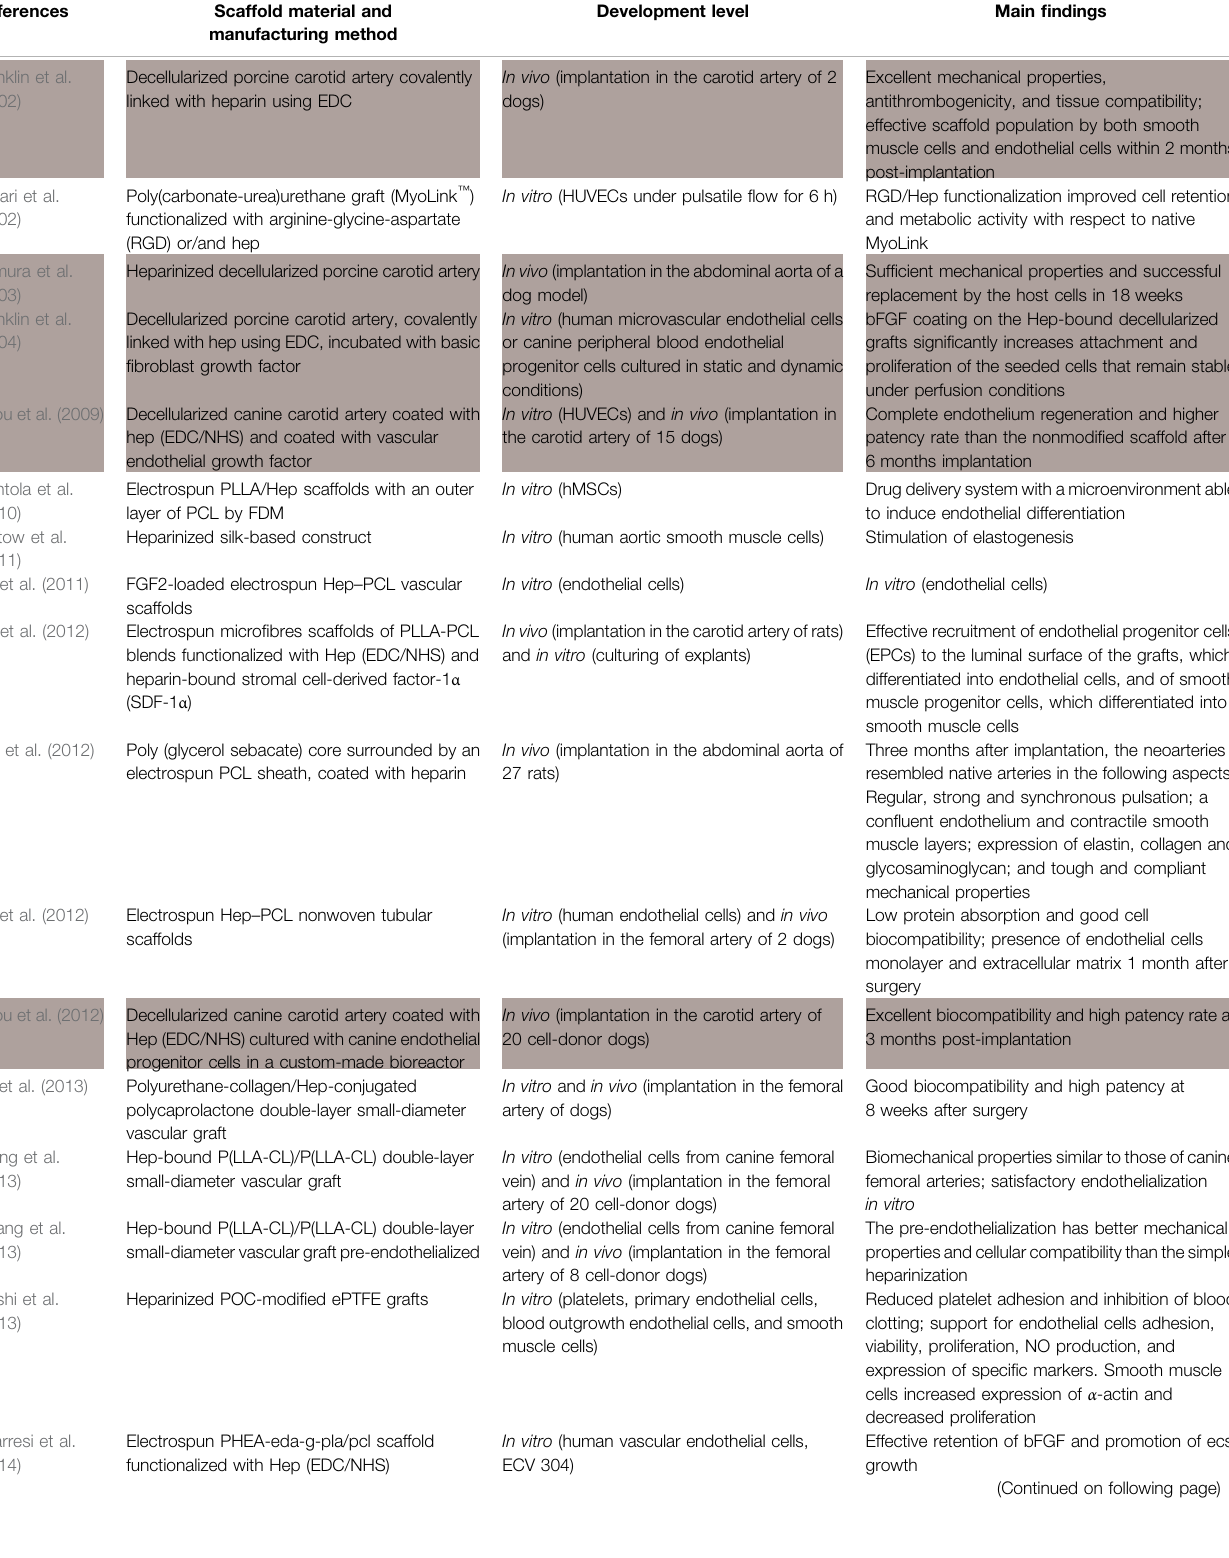
TABLE 2 | Heparin-functionalized vascular scaffolds for small-caliber artery grafting. Acellular tissue engineered vessels (A-TEVs) (highlighted in